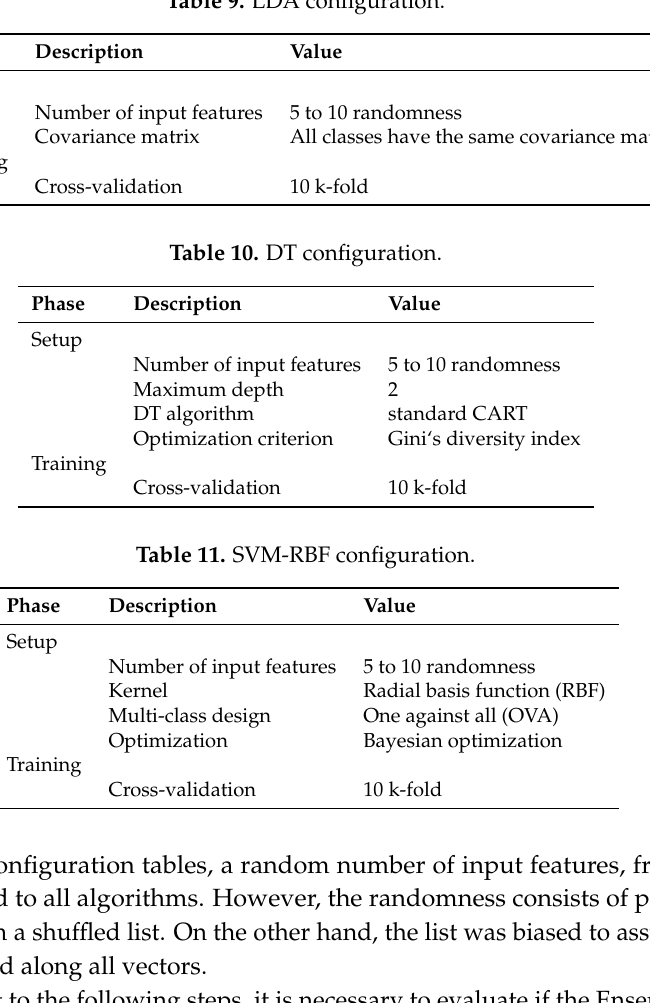
Table 9. LDA configuration.